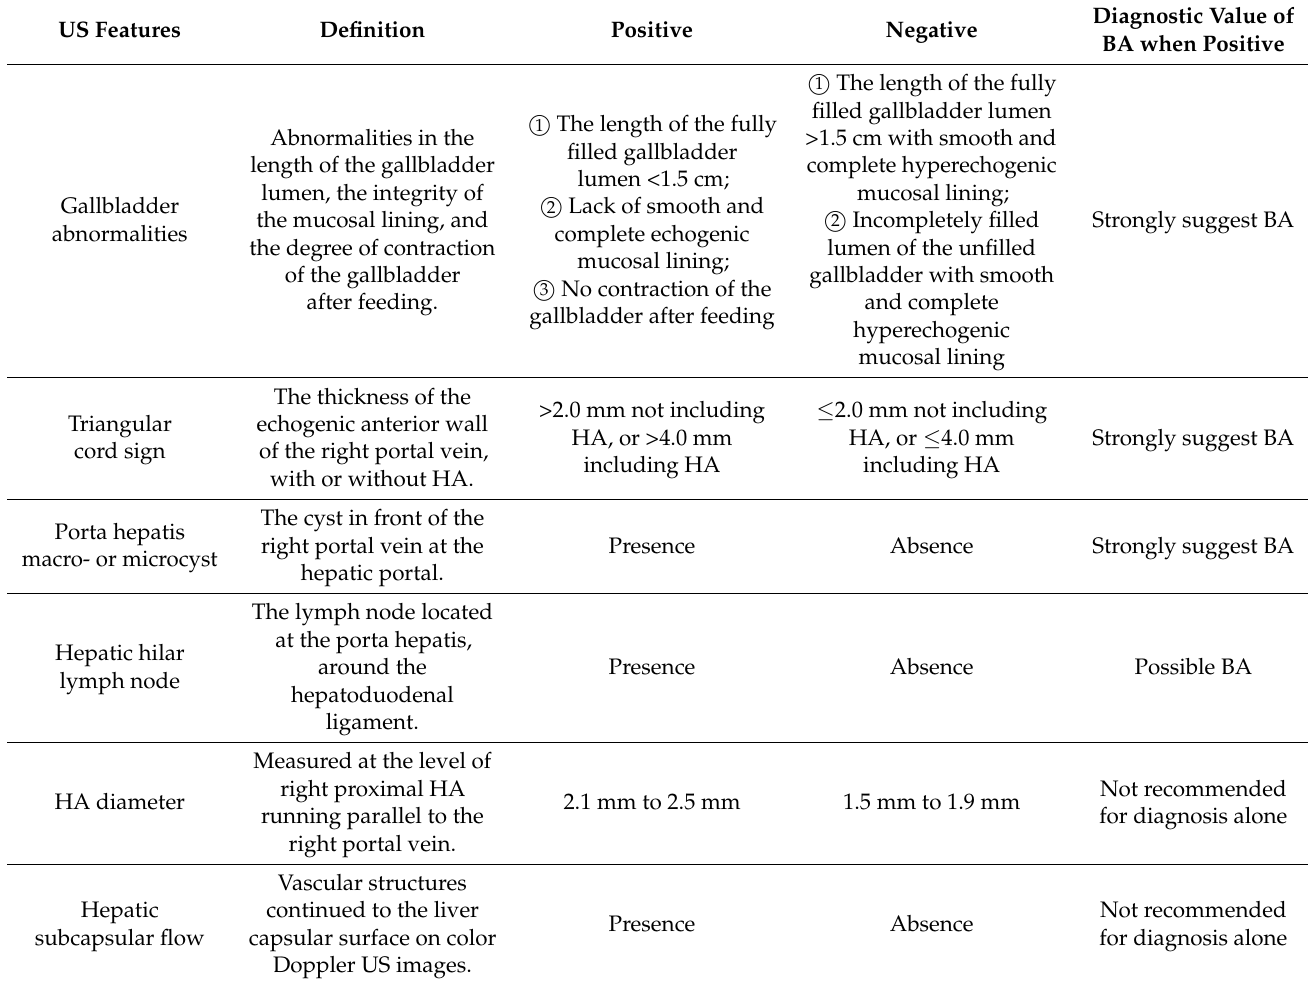
Table 1. Summary of various conventional ultrasound features used for diagnosing biliary